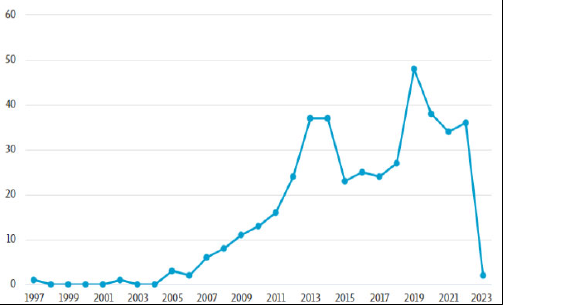
Fig. 1a. Biometric analysis of the words “Concrete” and “Photocatalytic” Source: Scopus scientific review